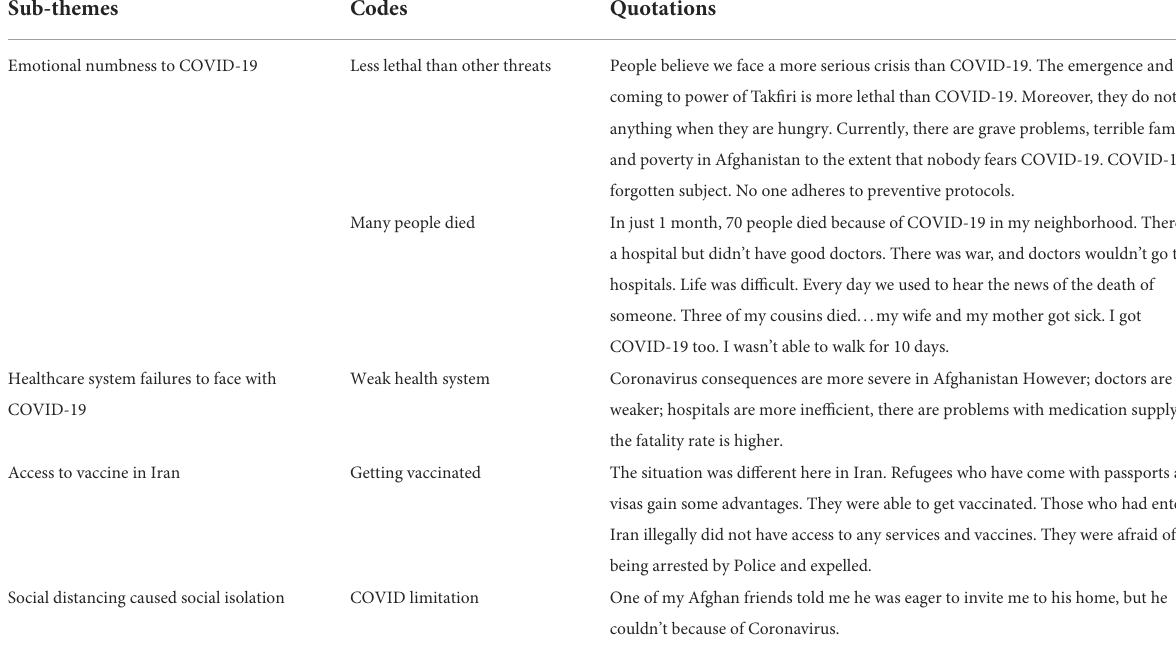
TABLE 4 Sub-themes, codes and quotations of the COVID-19